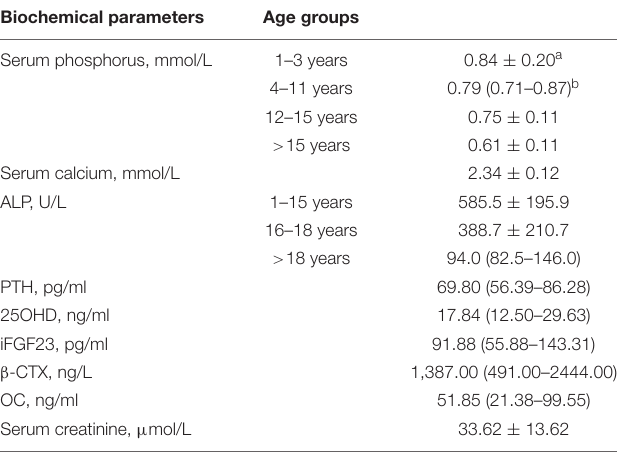
TABLE 2 | Biochemical features of patients with XLH. Biochemical parameters Age groups